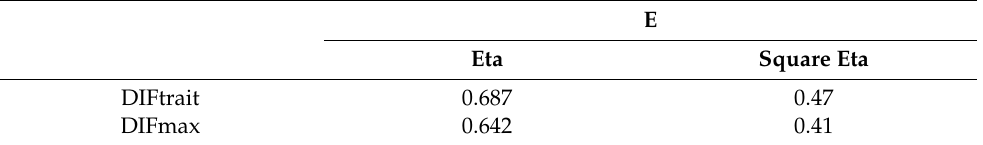
Table 4. Eta and Square Eta correlations between the categorized Ermakov–Lewis energy (E), as the dependent variable, and the non-categorized DIFtrait and DIFmax variables.